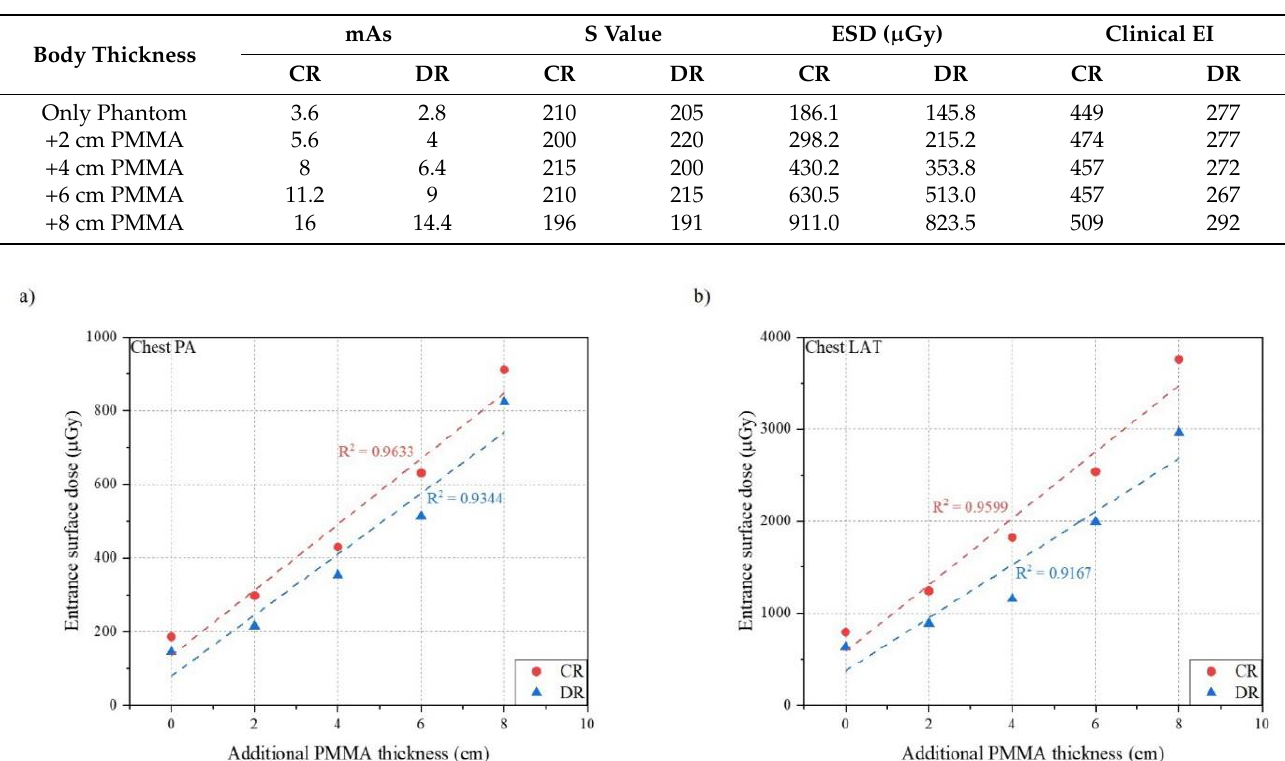
Figure 6. Relationship between phantom thickness and S value: ( a ) Chest PA; ( b ) Chest LAT. Figure 7. Relationship between phantom thickness and clinical exposure index: ( a ) Chest PA; ( b ) Chest LAT.